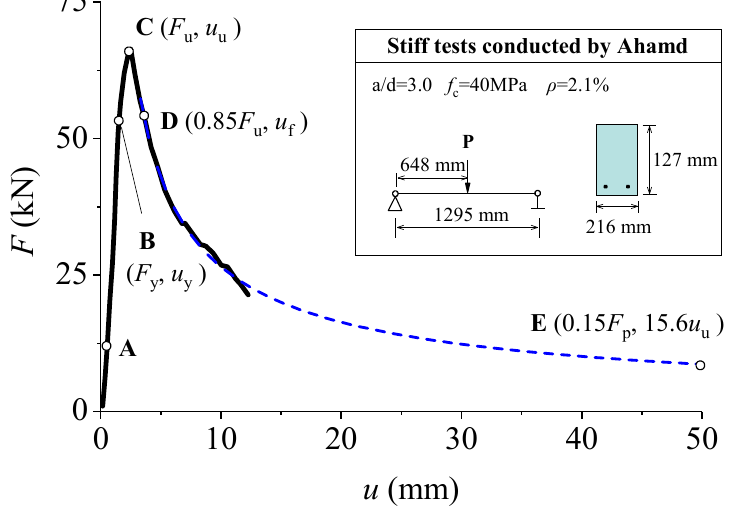
Figure 8. Typical load ‒ deflection curve of RC members [22].